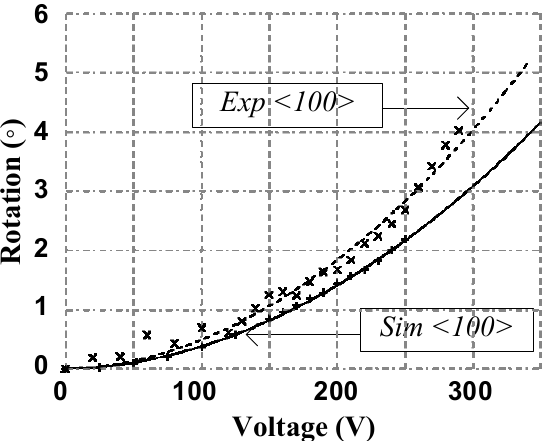
Figure 8. Measured and simulated platform angular displacement of the second design with fitting curves where the “+” data points represent simulated data, the solid line is a fit to the simulated data, the “ × ” data points represent experimental measurements, and the dotted line is a fit to the experimental measurements.